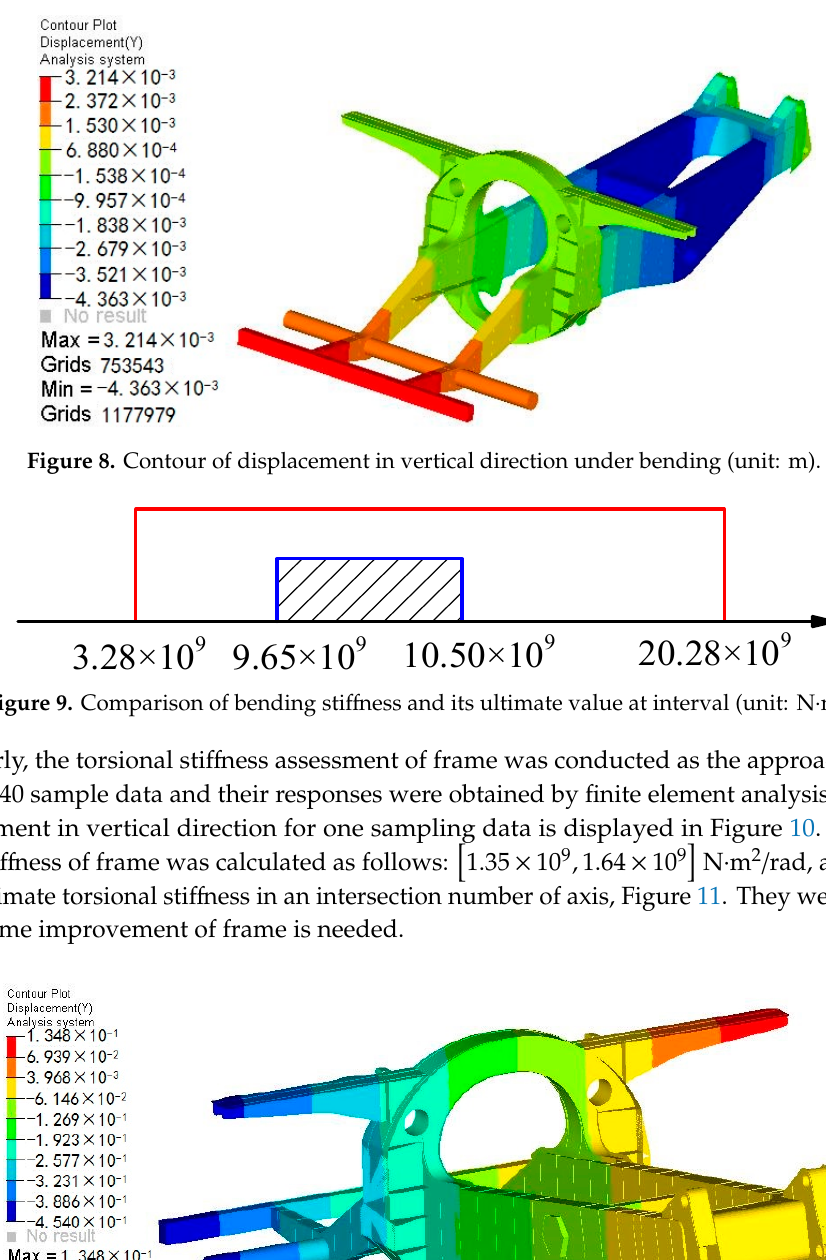
Table 7. Sample data and the corresponding responses.